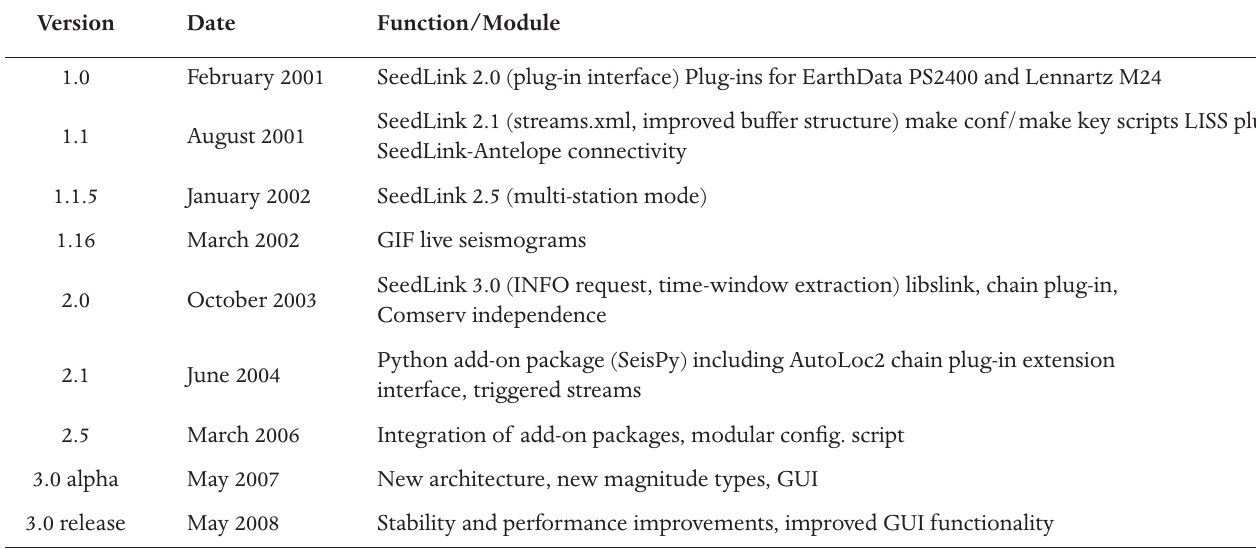
Table 2. SeisComP